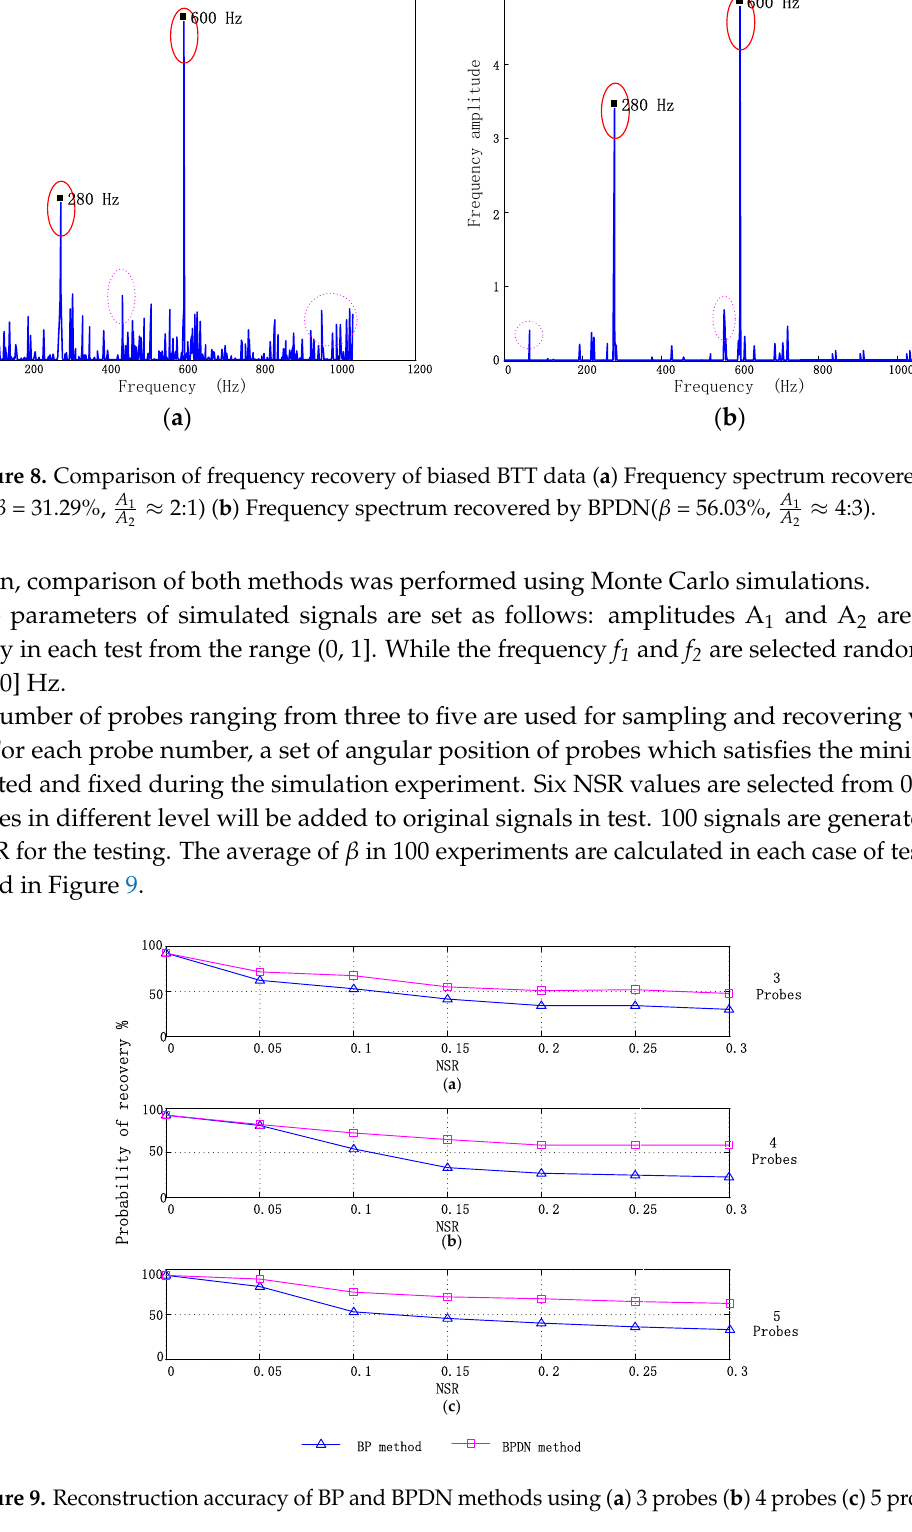
( b ) Figure 10. Vibration-based test rig ( a ) photo of testing rig ( b ) damaged testing blade of AL7075.